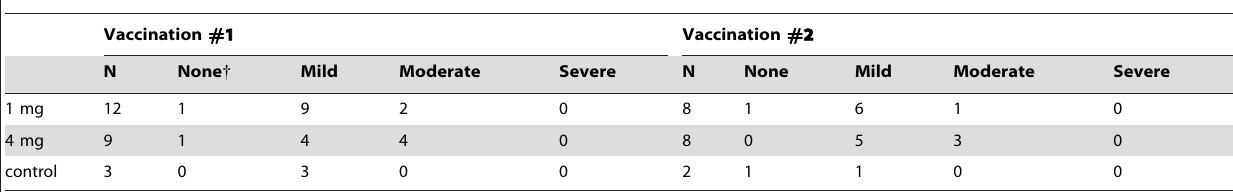
Table 2. Local reactions* within 7 days of